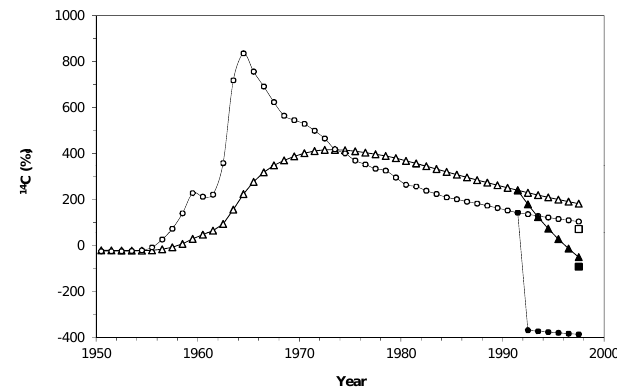
Fig. 1. Measured values of 14 CO 2 in the ambient air of the North- ern Hemisphere (open circles) and 14 CO 2 in the air supplied to the elevated CO 2 treatment (filled circles) compared to calculated 14 C values of soil organic matter in the control (open triangles) and the elevated CO 2 (filled triangles) treatments for an arbitrary turnover time of 10yr. Also shown are measured 1 14 C values for the light fraction of sandstone topsoil (0–15cm) in the control plots (open square, 1 14 C = 72‰) and the elevated CO 2 plots (filled square, 1 14 C =− 92‰) in